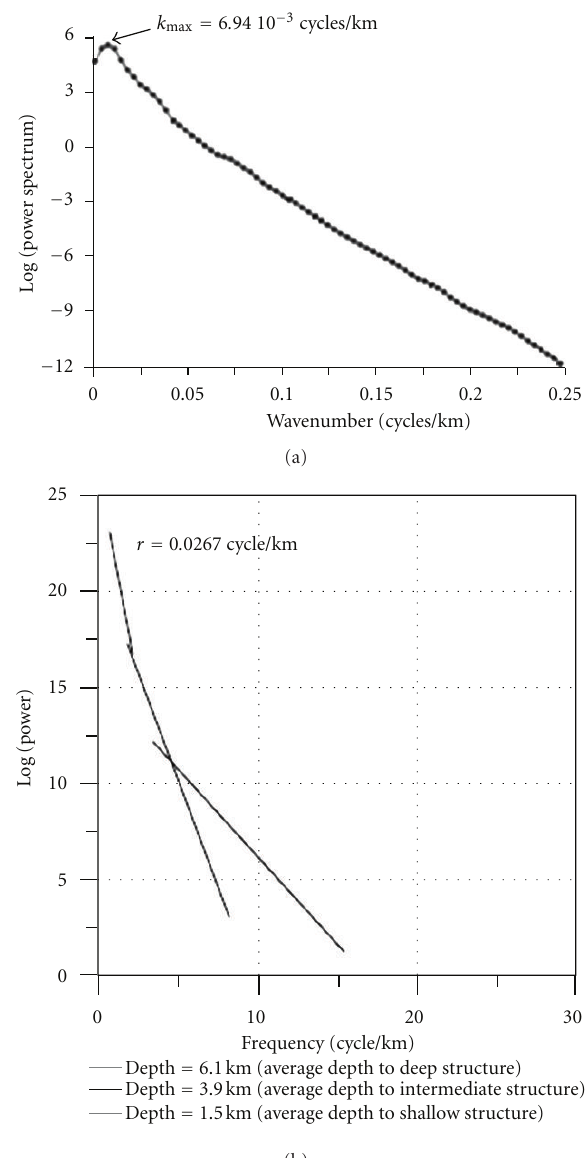
Figure 13: (a) Radially averaged power spectrum from aeromag- netic data after Blanco-Montenegro et al. [47]. (b) Example of average power spectrum of aeromagnetic anomaly map with depth to the top of magnetic sources ( z t ) estimated using least-square method after El-Qady et al.